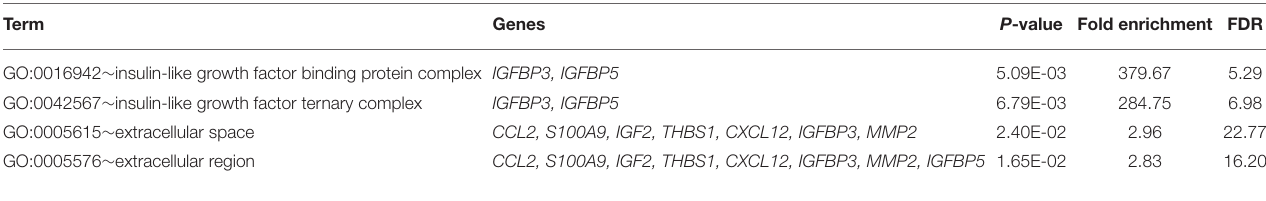
TABLE 2 | Gene ontology analysis for cellular component of genes involved in the ceRNA regulation network in ACC. Term Genes P -value Fold enrichment FDR